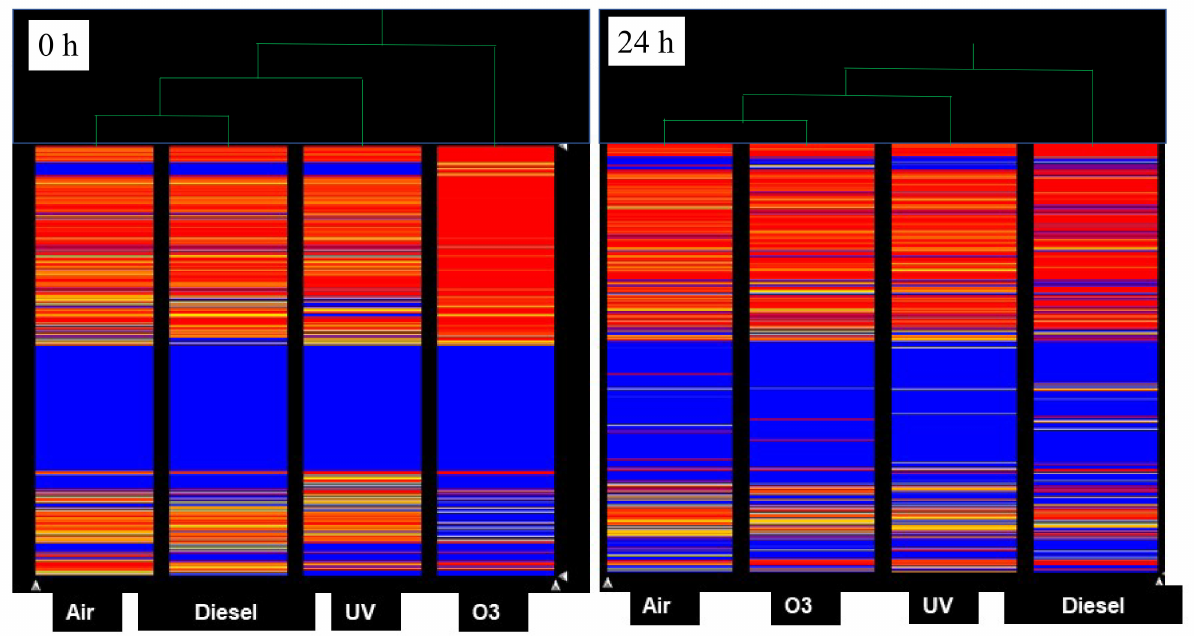
Figure 4. Hierarchical Cluster Analysis (HCA) reporting the expression of the 2549 miRNAs (colored horizontal bars) tested at time 0 ( left panel ) and 24 h ( right panel ) in samples either untreated (air) or treated with pollutants (ozone, diesel, and UV). Columns report miRNA expression profiles for each experimental condition. Similar expression profiles are linked in the upper hierarchical tree (green), thus being located nearby, while different expression profiles are located far away in the hierarchical